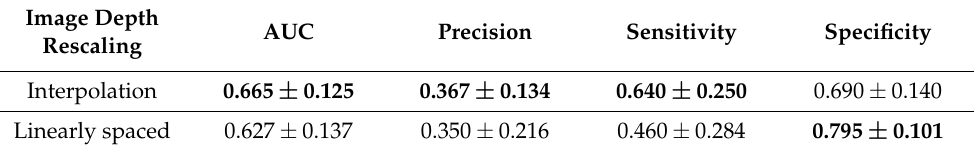
Table 7. Performance results when considering the addition of a manifold regularisation term to the discriminator loss.